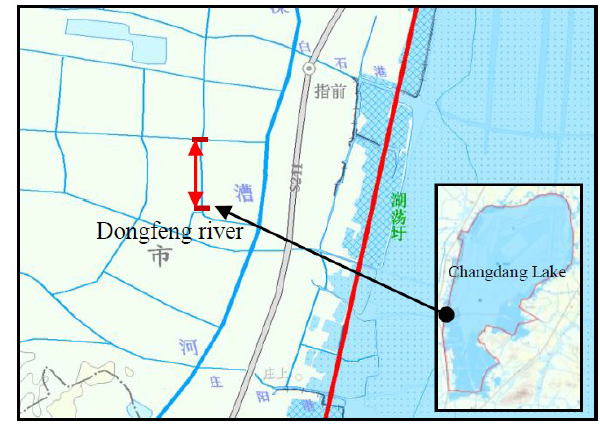
Figure 1. Location of test site, Dongfeng river.